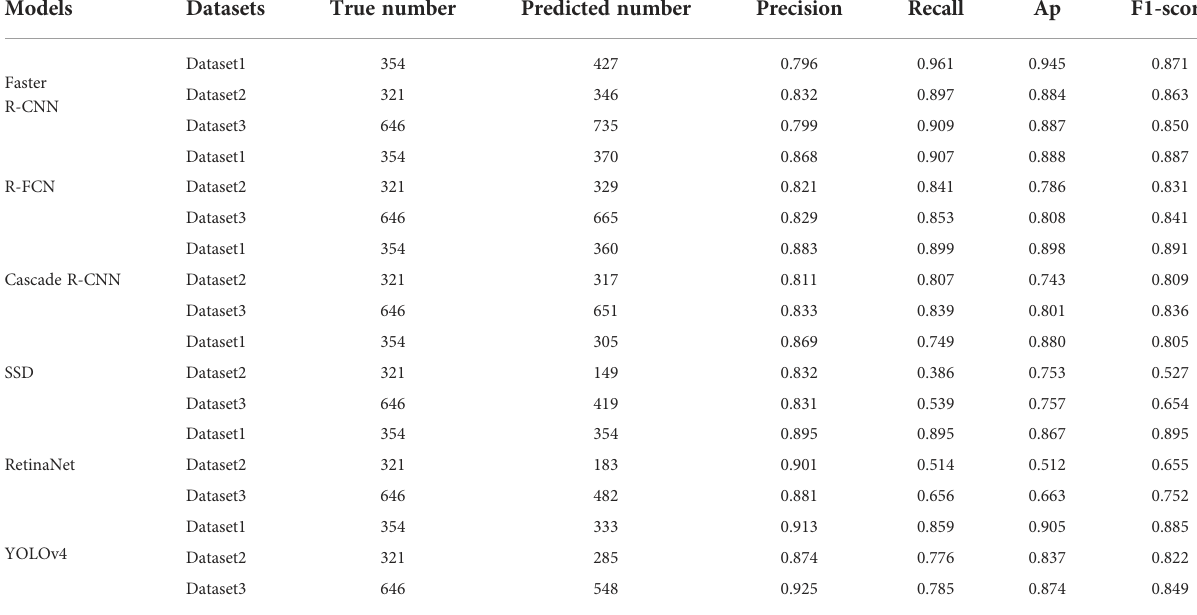
TABLE 5 The performances of different models using three datasets.